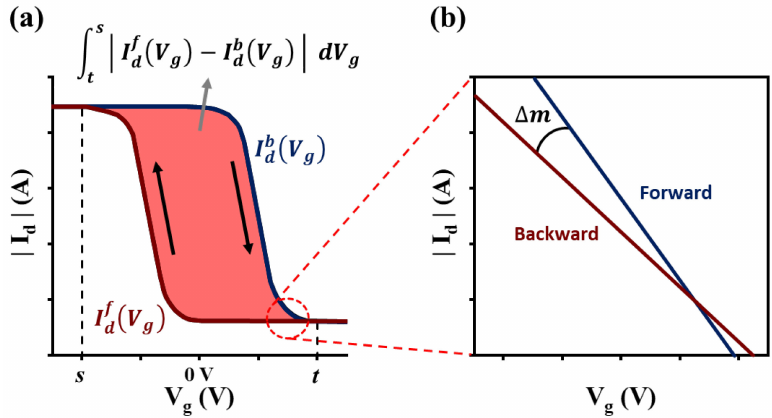
Figure 4. Hysteresis metrics: ( a ) hysteresis index [28] and ( b ) slope difference [29]. Slope Difference: The slope difference ∆ m as a hysteresis parameter was